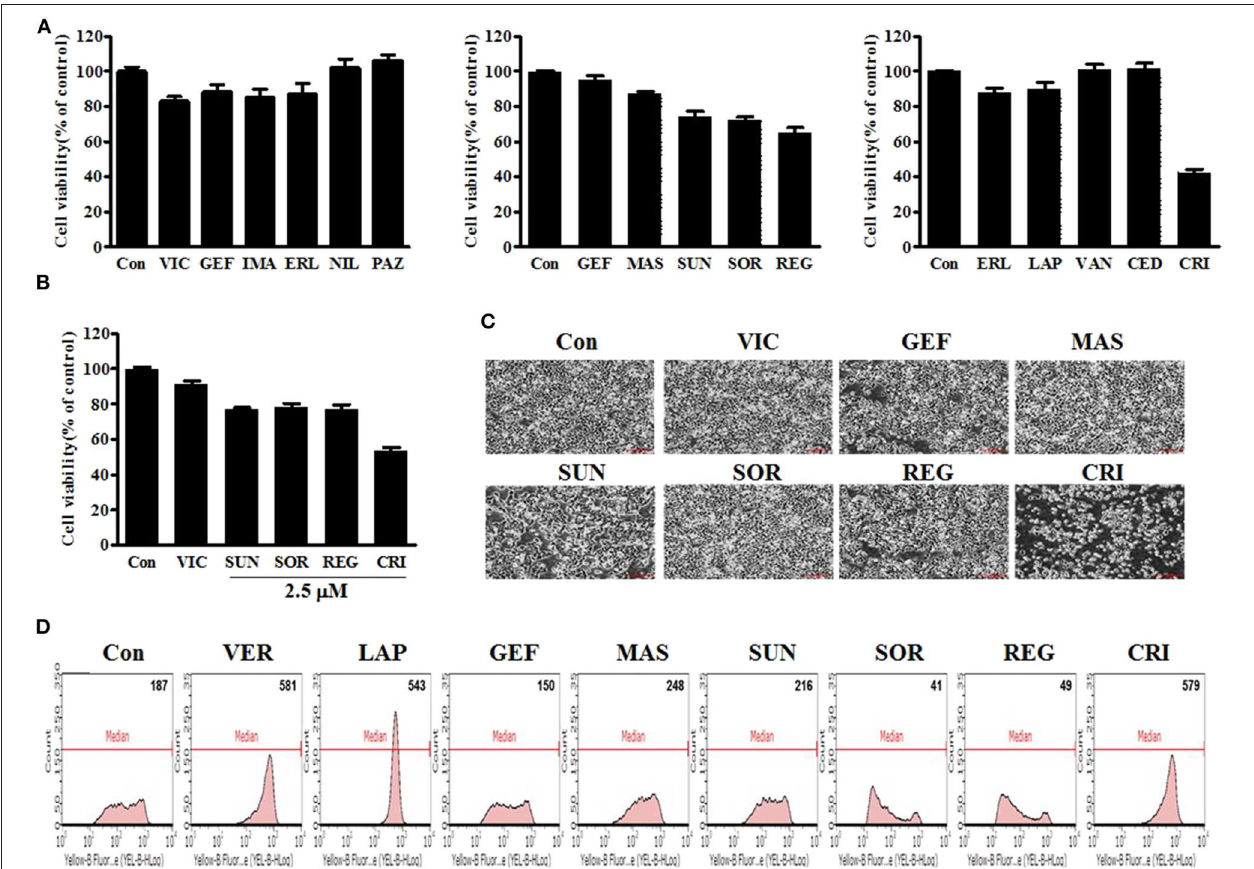
FIGURE 1 | Low-dose crizotinib sensitizes P-gp-overexpressing drug-resistant KBV20C cancer cells to a greater extent than the 12 other TKIs. (A) KBV20C cells were plated on 96-well plates and grown to 30–40% confluence. The cells were then stimulated for 48h with VIC, 5nM vincristine; GEF, 5 µ M of gefitinib; IMA, imatinib; ERL, erlotinib; NIL, nilotinib; PAZ, pazopanib; MAS, masatinib; SUN, sunitinib; SOR, sorafenib; REG, regorafenib; LAP, lapatinib; VAN, vandetanib; CED, cediranib; CRI, crizotinib; or 0.1% DMSO (Con). Cell viability assay was performed as described in “Materials and methods.” The data are presented as the mean ± S.D. of at least in triplicate experiments. (B) KBV20C cells were plated on 96-well plates and grown to 30–40% confluence. The cells were then stimulated for 48h with VIC, 5nM vincristine; SUN, 2.5 µ M of sunitinib; SOR, sorafenib; REG, regorafenib; CRI, crizotinib; or 0.1% DMSO (Con). Cell viability assay was performed as described in “Materials and methods.” (C) KBV20C cells were grown on 60 mm-diameter dishes and treated with VIC, 5nM vincristine; GEF, 5 µ M of gefitinib; MAS, masatinib; SUN, sunitinib; SOR, sorafenib; REG, regorafenib; CRI, crizotinib; or 0.1% DMSO (Con). After 1 day, all cells were observed using an inverted microscope at × 4 magnification. (D) KBV20C cells were grown on 60 mm-diameter dishes and treated with VER, 10 µ M verapamil; LAP, 5 µ M of lapatinib; GEF, gefitinib; MAS, masatinib; SUN, sunitinib; SOR, sorafenib; REG, regorafenib; CRI, crizotinib; or 0.1% DMSO (Con). After 4h, all cells were stained with rhodamine and examined